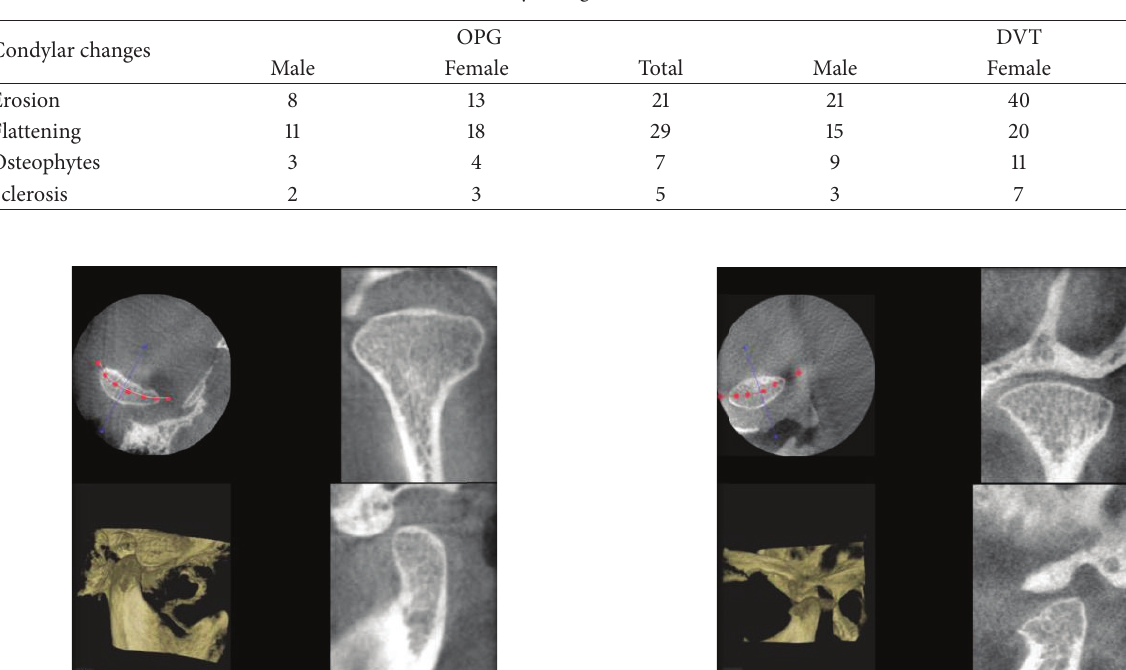
Table 7: Most common bony changes in male and female in OPG and DVT.